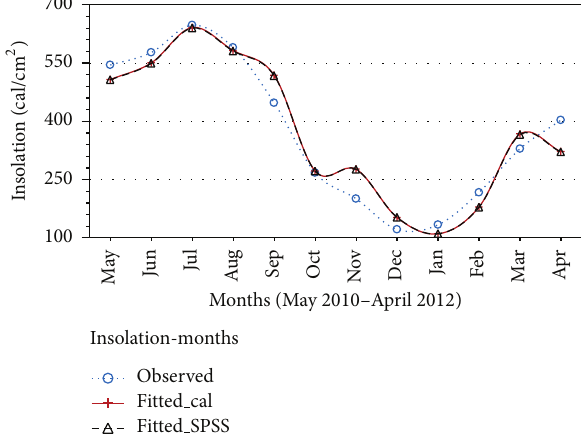
Figure 2: The monthly change of wind speed. 𝑦 = (3228.488769531) − (80.144126892) 𝑥 𝑄